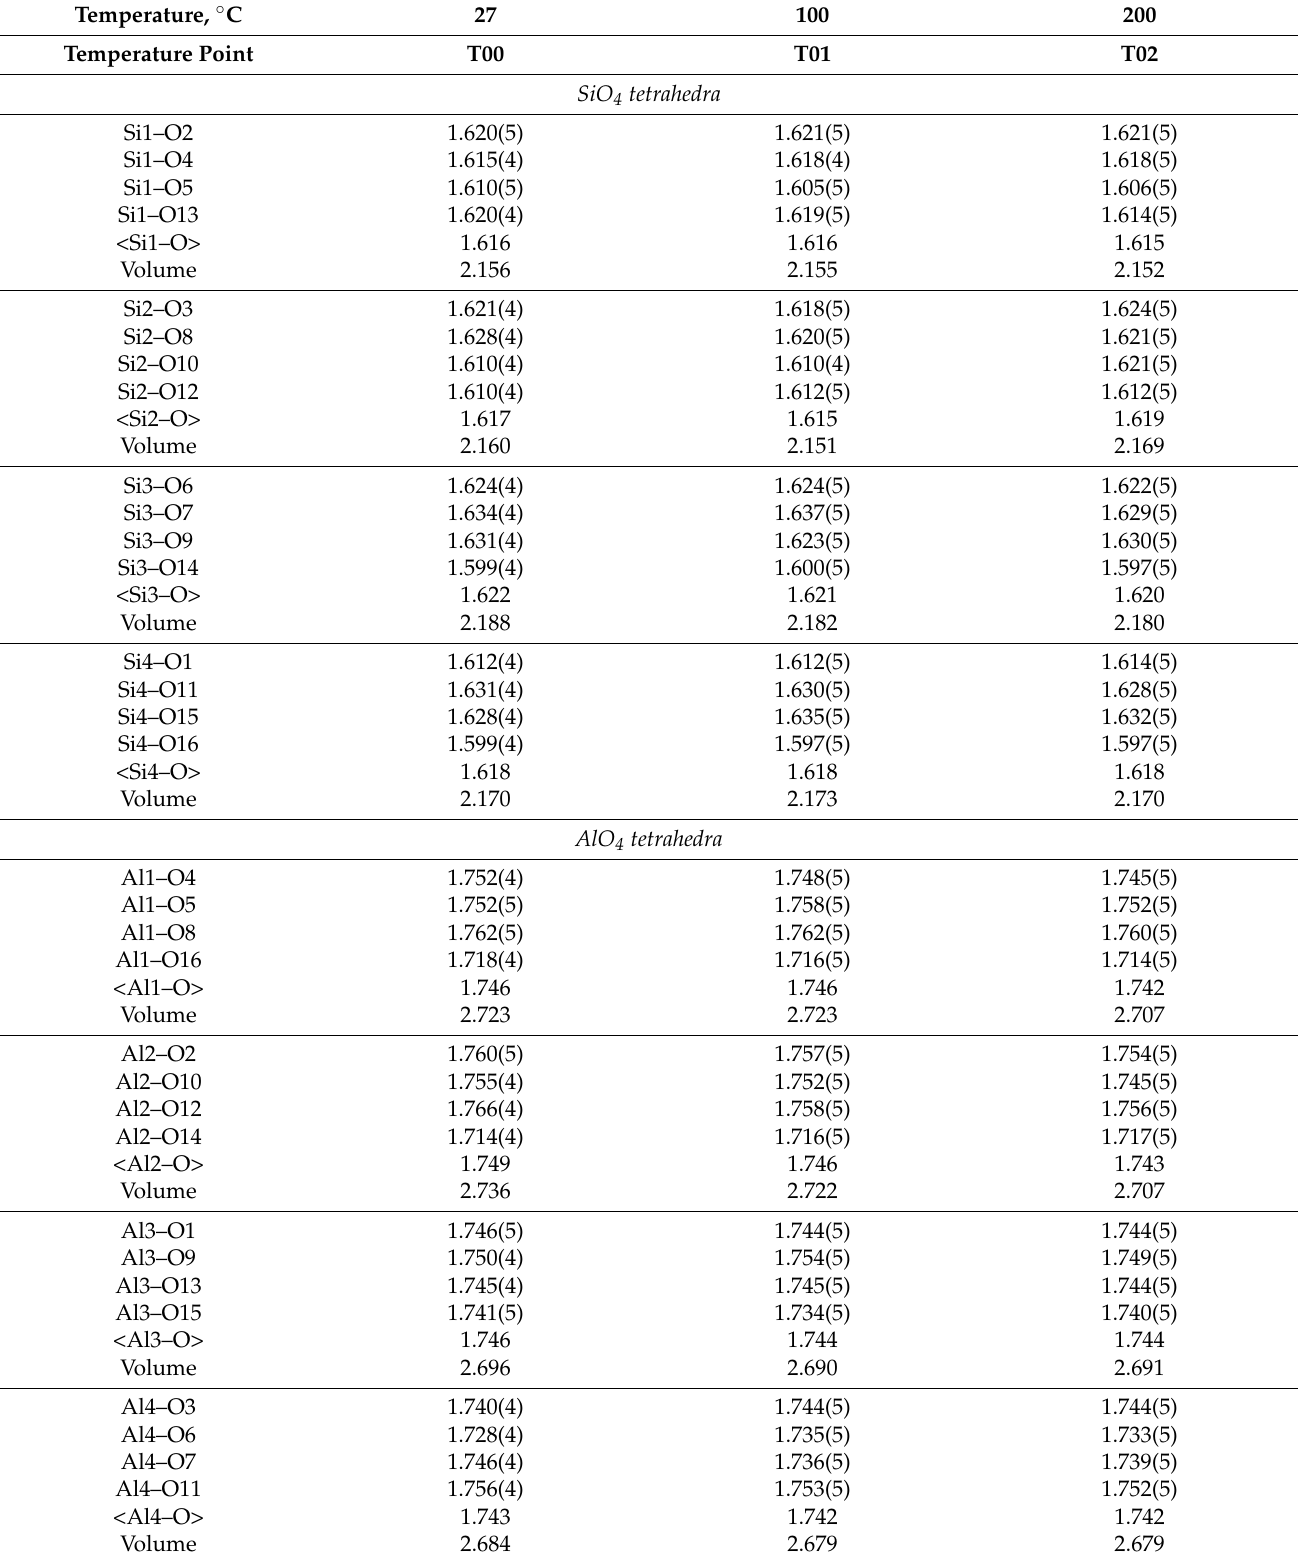
Table 4. Bond distances and polyhedral parameters in slawsonite SrAl 2 Si 2 O 8 at different temperatures in the P –1 space